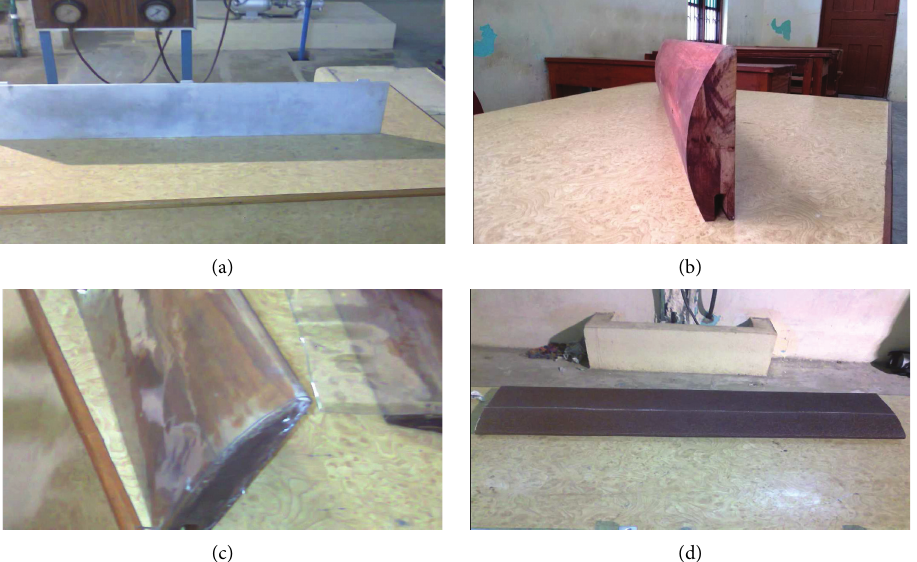
Figure 5: Spillway weir materials. (a) Concrete profile. (b) Teak wood profile. (c) SS-304-coated profile. (d) SS-316-coated